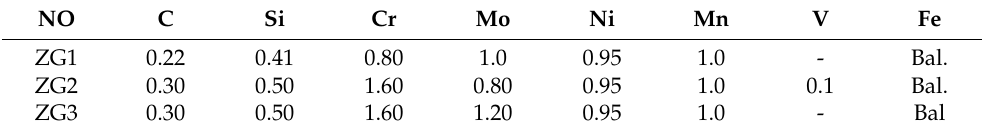
Table 1. Chemical compositions (wt%) of the cast steels ZG1, ZG2, and ZG3. NO